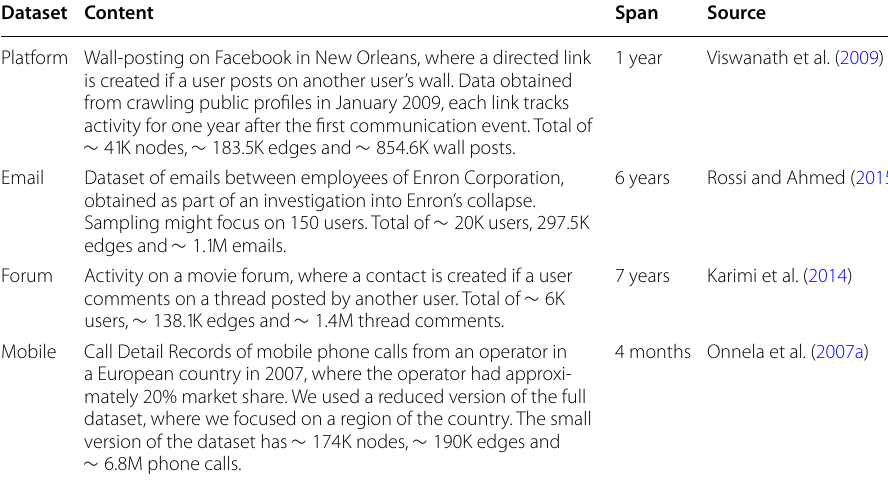
Table 1 Description of the four reference datasets, including the observation span and source Dataset Content Span